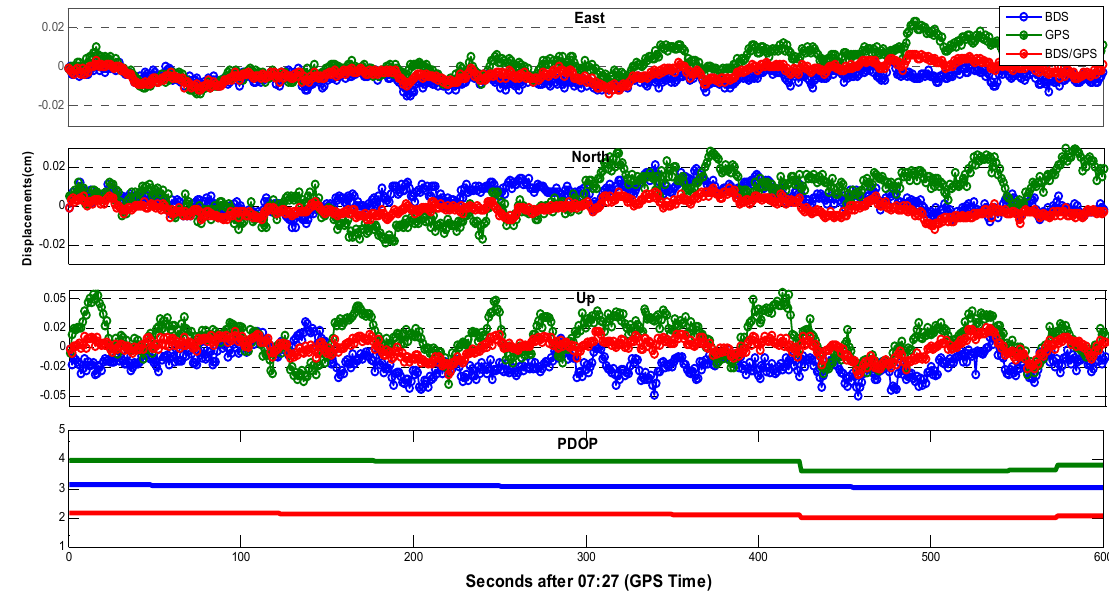
Figure 2. TPP solutions of BDS, GPS and BDS/GPS at stationary station GMSD on 30 December 2013. Additionally shown is the corresponding PDOP, which specifies the effect of navigation satellite constellation geometry on positional precision. Note that, since the station did not move, the above graphs can be used to evaluate the expected uncertainty of TPP displacements.